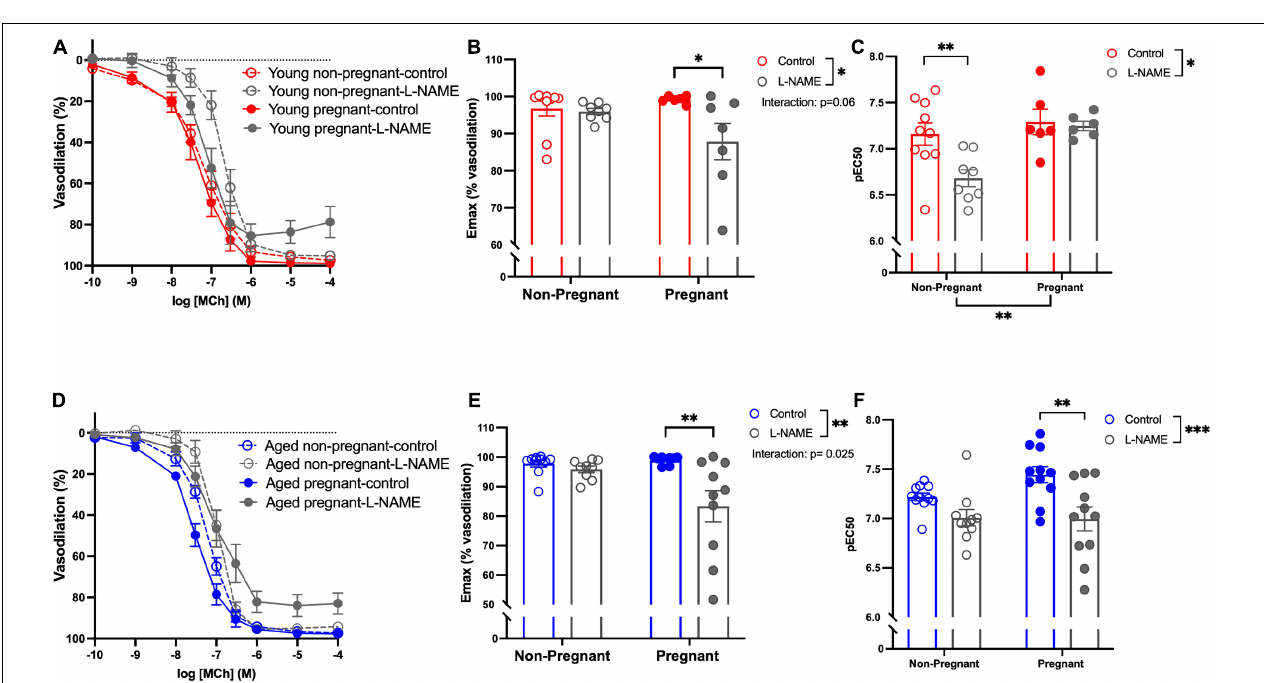
FIGURE 2 | No differences in the endothelium-dependent vasodilation in young and aged non-pregnant and pregnant rats. (A) Endothelium-dependent vasodilation responses to increasing doses of methylcholine (MCh) in mesenteric arteries of young (3–4 months; in red) and aged (9–9.5 months; in blue) pregnant (on gestational day 20; closed circles) and non-pregnant (age-matched; open circles) rats. (B) Data summary of sensitivity to MCh (pEC 50 ). Data are presented as mean ± SEM; analyzed by two-way ANOVA with Sidak’s multiple comparisons post hoc test; n = 9–16/group.